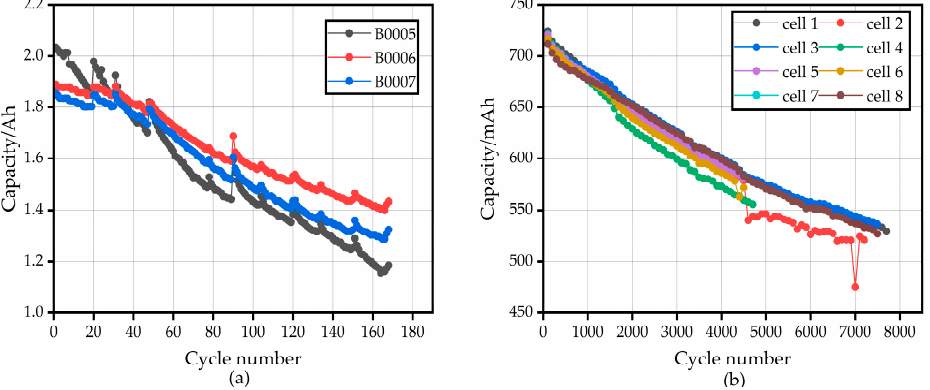
Figure 1. ( a ) Capacity curves of NASA dataset; ( b ) Capacity curves of Oxford dataset.